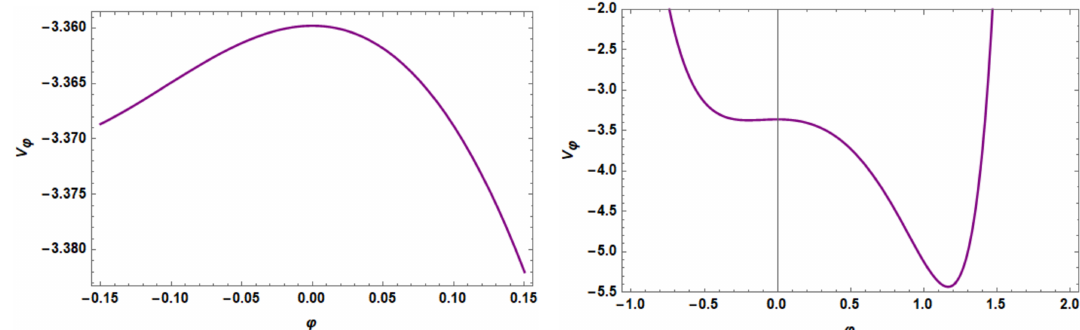
Figure 19. Here V ϕ is plotted as a function of ϕ . Left figure is showing the (expected) local structure of V ϕ near ϕ = 0 whereas the right figure corresponds to global structure of the potential.